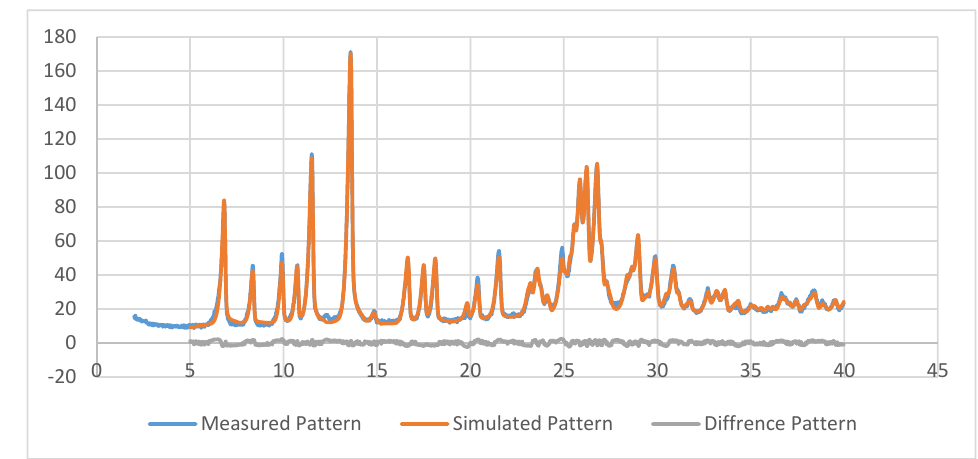
Figure 8. Rietveld refinement of the X-ray powder diffraction (XRPD) data for THL-NIC cocrystals extruded at 500 g/h (Top) and 1.5 kg/h (Bottom), after 12 months at accelerated conditions where the measured pattern is represented with the blue line, the simulated pattern with the red line and the different pattern in grey. Refinement values displayed below.